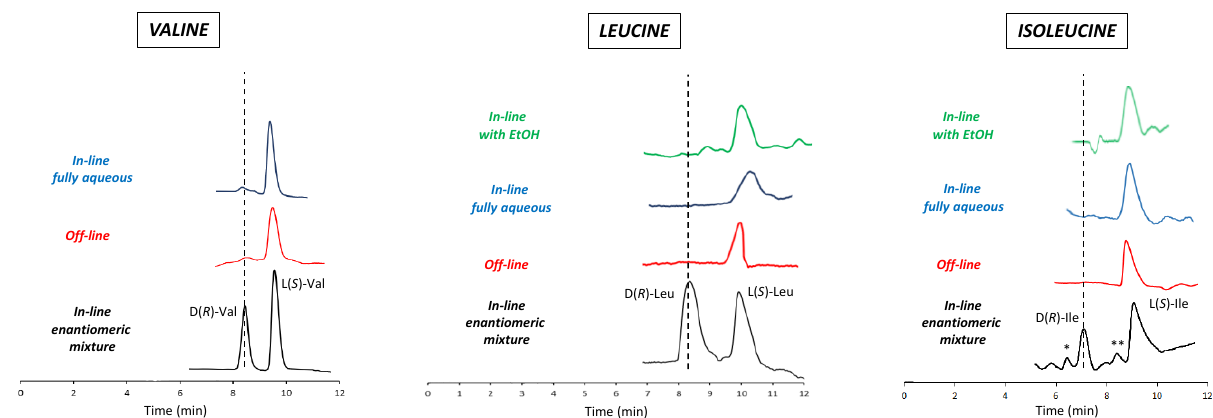
Figure 4. Chromatograms obtained for all three BCAAs in various types of analyses. From the bottom to the top: chromatogram of the artificial enantiomeric mixture analyzed in-line with the implemented LC-LC system (under fully aqueous condition in the achiral separation, black line); chromatogram of the fraction collected during the achiral separation (first dimension) and then reinjected into the chiral column (second dimension) after drying under vacuum and re-solubilized in the chiral selector/Cu(II)-containing eluent (off-line mode; red line); chromatogram of the fraction switched from the first (achiral) to the second (chiral) column, using the fully aqueous mobile phase in the first dimension (blue line); chromatogram of the fraction switched from the first (achiral) to the second (chiral) column, using the water/EtOH-containing mobile phase in the first dimension (green line). Chromatograms with red, blue, and green lines refer to the analysis of real samples (that is, the extract from the food supplement). Experimental conditions: column, Prevail RP18 (Grace, Sedriano, Italy) (250 mm × 4.6 mm i.d., 5 μm, 110 Å pore size); mobile phase, fully aqueous solution with 0.5 mM ( S )-OBS and 0.25 mM Cu(NO 3 ) 2 ; column temperature, 25 °C; flow rate, 1.0 mL/min for Ile and Leu, 0.5 mL/min for Val; UV @ 254 nm.